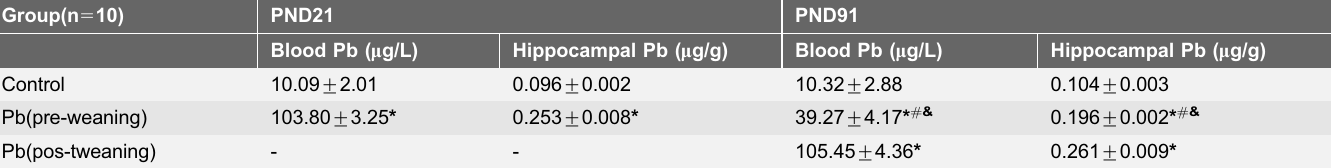
Values are expressed as the means ¡ S.D. of 10 samples in each group. The symbol of ‘-’ indicates that there is no animal in that group at PND21. * p , 0. 05, versus Control; # p , 0. 05, versus the group of Pb(post-weaning); & p , 0. 05, compared between PND21 and PND91 in each group (Wilcoxon Rank-Sum test).